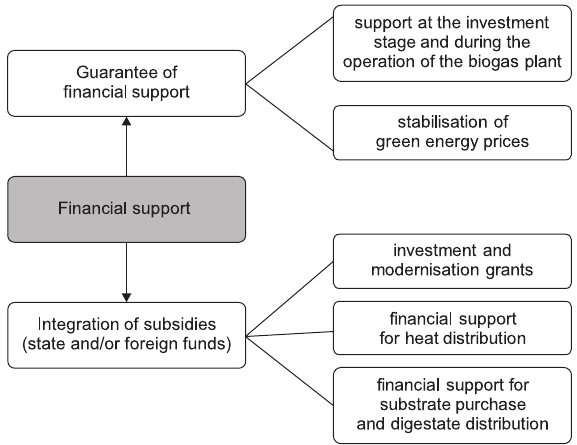
Fig. 3. Financial support for the agricultural biogas market in Poland. Source: own study based on research